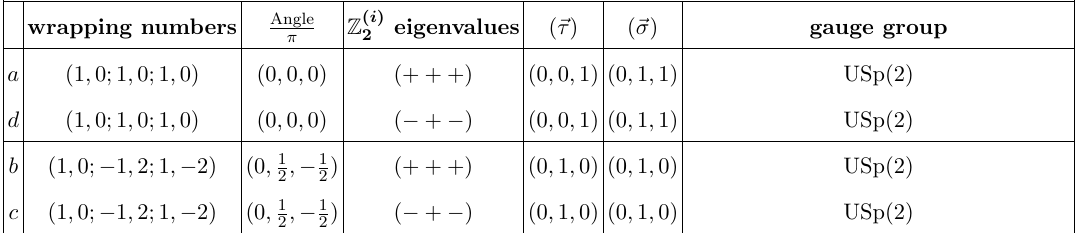
Table 13 . D6-brane con(cid:12)guration of a global model on the aAA lattice of T 6 = ( Z 2 (cid:2) Z 6 (cid:2) (cid:10) R ) with discrete torsion and with (cid:10) R Z (3) as the exotic O6-plane orbit. The D6-branes b and c are 2 chosen identical to all L-R symmetric models and the PS II model in tables 18 and 23, respectively.